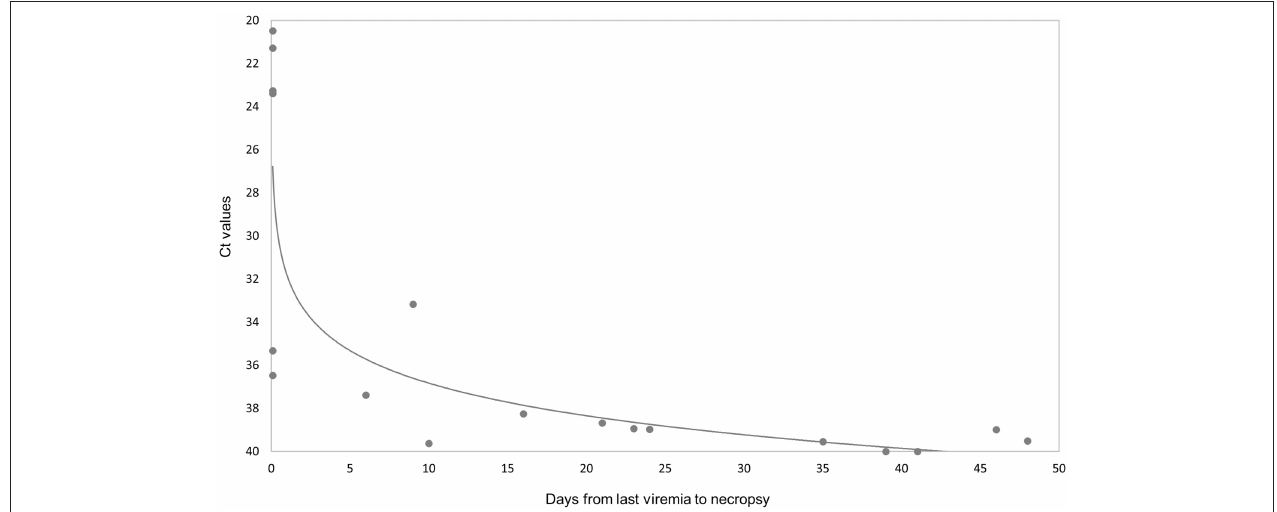
FIGURE 6 | Comparison of ASFV DNA levels (Ct values from real-time PCR results) in 16 post-mortem tissues with the number of days from last viremia detected until necropsy. The Ct values are inversely related to the level of virus